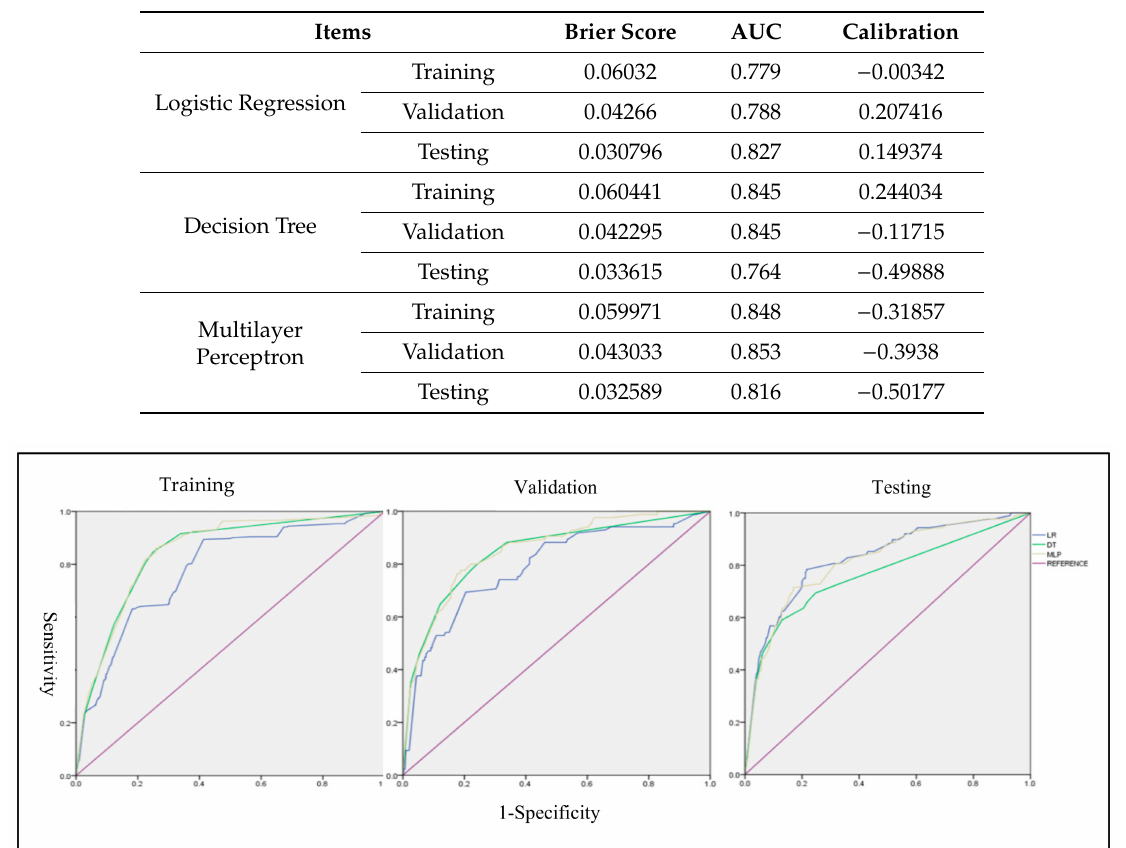
Table 2. Model performance test.